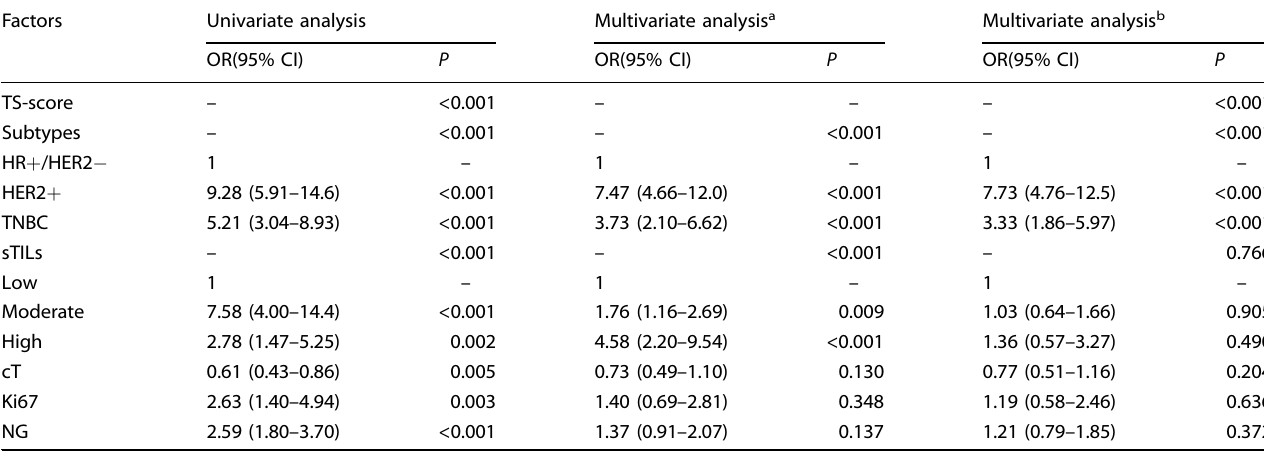
Table 2. Univariate and multivariate analysis of TS-score correlating with pCR in primary cohort.